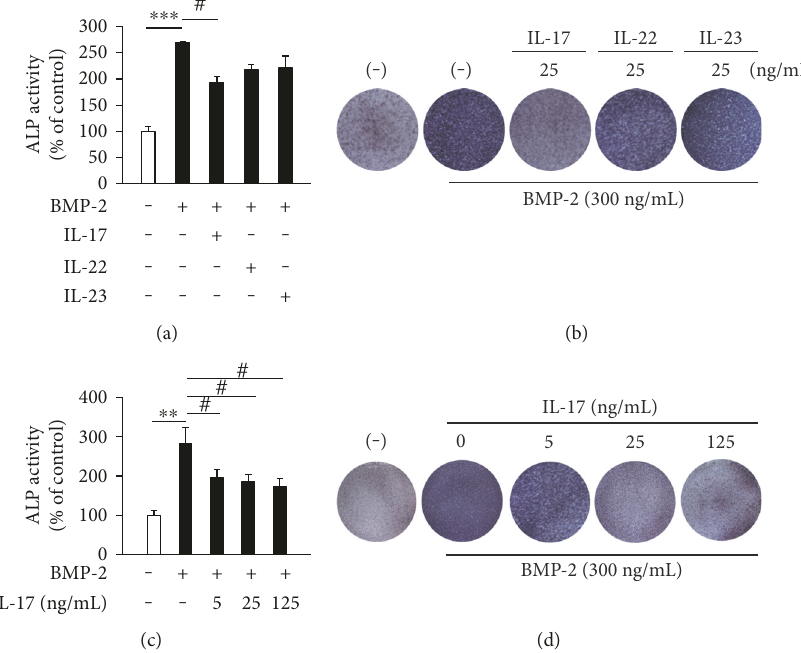
Figure 5: The e ff ects of IL-17 on ALP activity and ALP mass of primary osteoblasts. (a) ALP activity in primary osteoblasts cultured with BMP-2 (300ng/ml) in the presence of IL-17 (25 ng/ml), IL-22 (25 ng/ml), or IL-23 (25 ng/ml) for 7 days. ∗∗∗ p < 0 001 compared with untreated control; # p < 0 05 compared with the cells stimulated with BMP-2 alone. (b) Staining for ALP in primary osteoblasts cultured with BMP-2 (300ng/ml) in the presence of IL-17 (25 ng/ml), IL-22 (25 ng/ml), or IL-23 (25 ng/ml) for 7 days. (c) ALP activity in primary osteoblasts cultured with BMP-2 (300ng/ml) in the presence of di ff erent concentrations of IL-17 (0, 5, 25, and 125ng/ml) for 7 days. ∗∗ p < 0 01 compared with untreated control; # p < 0 05 compared with the cells stimulated with BMP-2 alone. (d) Staining for ALP in primary osteoblasts cultured with BMP-2 (300ng/ml) in the presence of di ff erent concentrations of IL-17 (0, 5, 25, and 125ng/ml) for 7